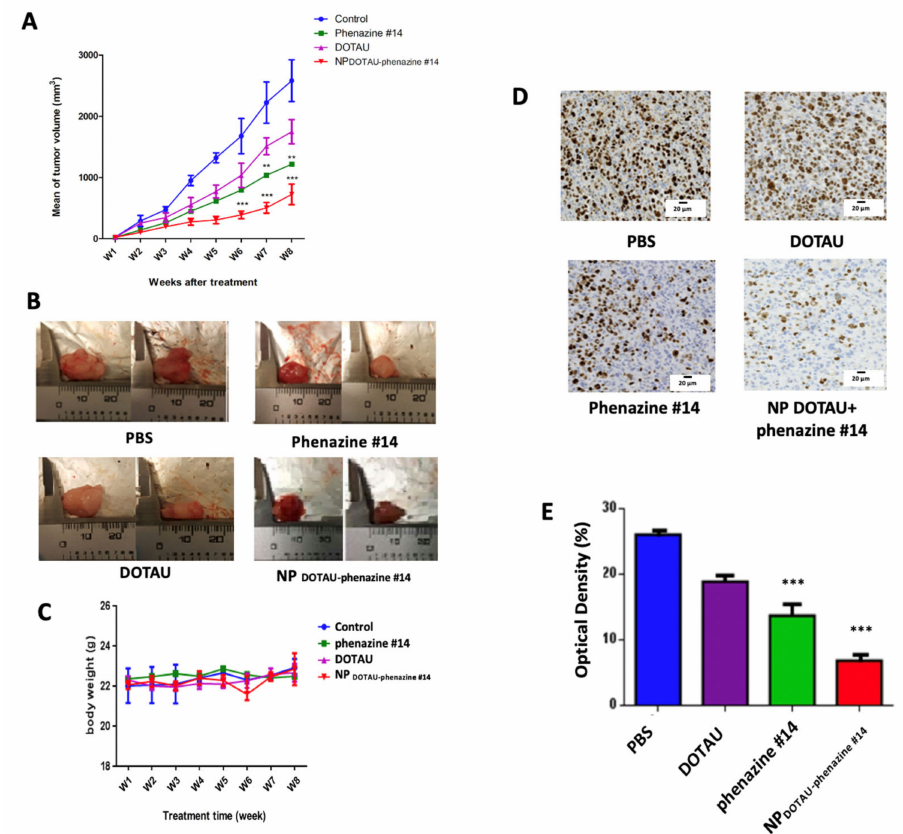
Figure 5. NP DOTAU-phenazine #14 decreased tumor volume in vivo. ( A ) NP DOTAU-phenazine #14 significantly enhanced an- ticancer activity in tumor-xenograft mice. NOD SCID mice were treated with free phenazine #14 (1 mg/kg), DOTAU, and NP DOTAU-phenazine #14 (2 mg/kg) via i.p. administration (twice per week, n = 8). PBS group was used as control ( n = 6). Tumor volume was measured twice per week. Data are shown as mean ± SEM. ( B ) Representative pictures of the PC-3-derived xenograft tumors harvested from mice that received i.p. compound NP DOTAU-phenazine #14 or control-PBS, phenazine #14, and DOTAU after an 8-week treatment. ( C ) The body weight of the mice during the treatment time. Mouse body weight was measured twice per week. The graph shows that the treatments did not have side effects on body weight of the mice. Data are shown as mean ± SEM. ( D ) Ki-67 IHC staining of tumor tissues to assess tumor proliferation. ( E ) Distribution of tissue Ki-67 immunostaining intensity (measured as average optical density) according to the tumor treated with PBS, DOTAU, phenazine #14, and NPDOTAU-phenazine #14. Data are shown as mean ±